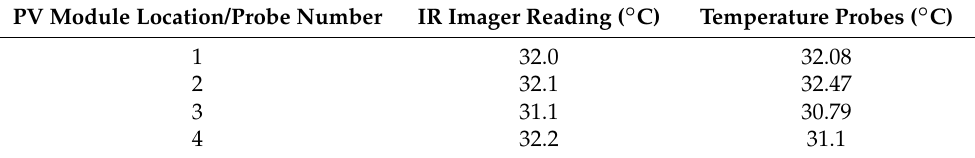
Table 1. Results of IR imager temperature and temperature probe readings.